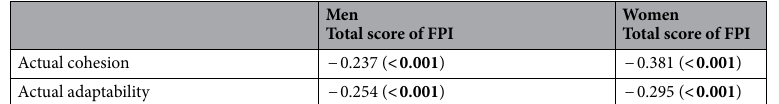
Men Total score of FPI